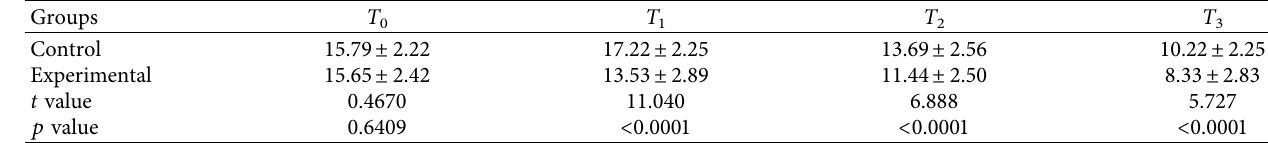
Table 5: The horizontal comparison of IL-6 between two groups at different time points ( x ± S , ng/L).